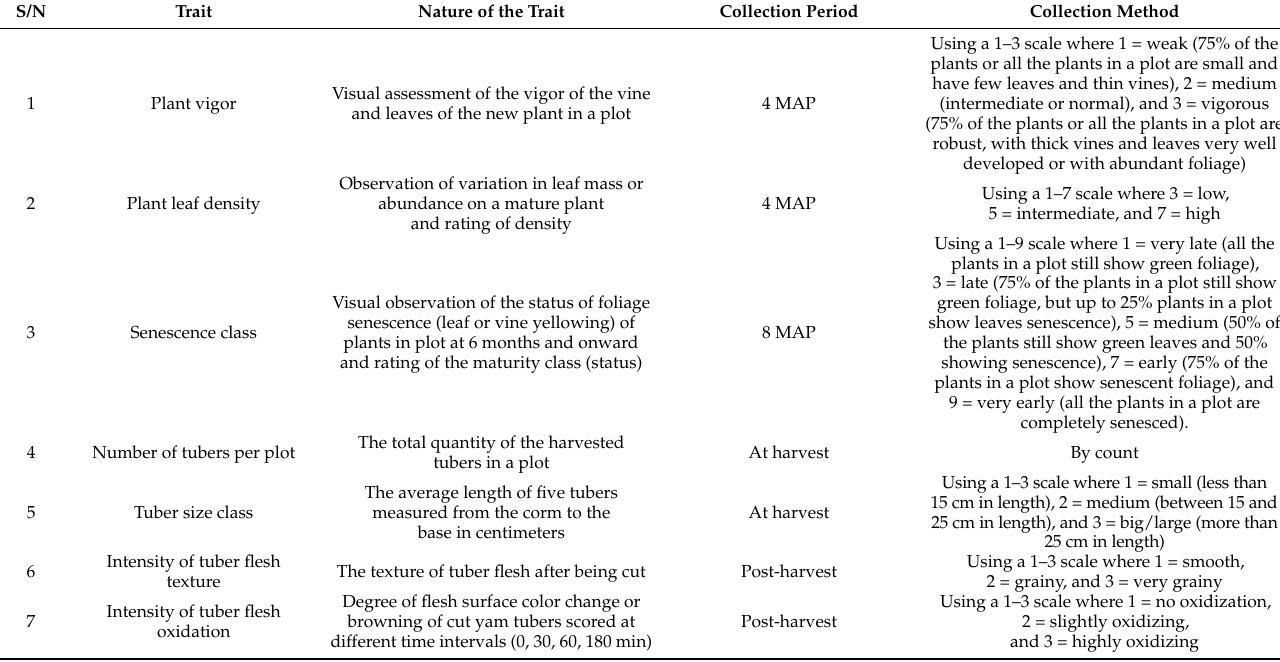
Table 2. List of some traits assessed during the trial